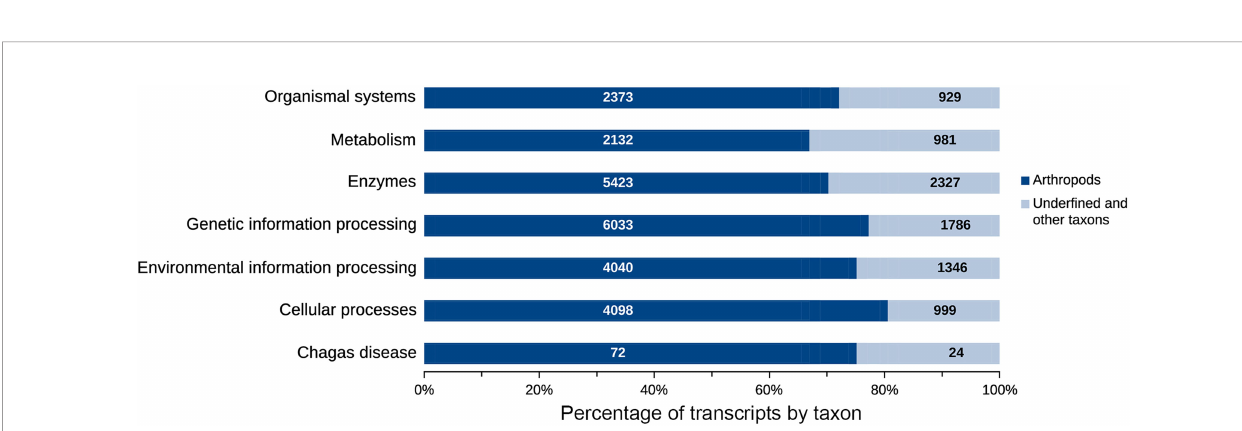
FIGURE 7 | Transcripts distribution according to functional classes. The genetic information processing (7,819) and enzymes (7,750) comprise most of the transcripts present in the salivary glands and intestine of R. neglectus . However, known to arthropods, functional transcripts of genetic information processing and cellular processes are the most diverse of the